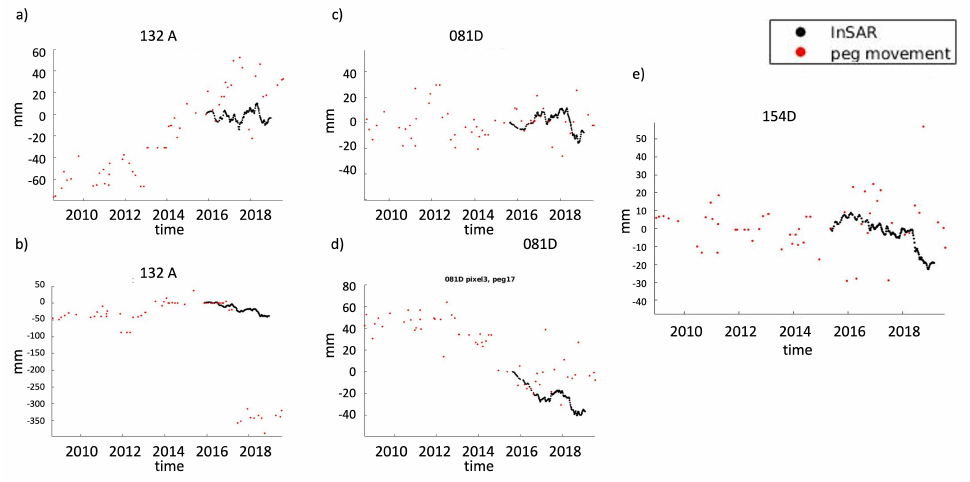
Figure 5. Comparisons between the motion of individual pegs and the closest InSAR pixel in the line-of- sight direction. These InSAR pixels correspond to the southern part of the slope where the flow lobes are located. Both time series show relative movement compared to the first date of InSAR acquisition. The InSAR data are extracted from ascending track 132A ( a , b ), descending track 081D ( c , d ) and descending track 154D ( e